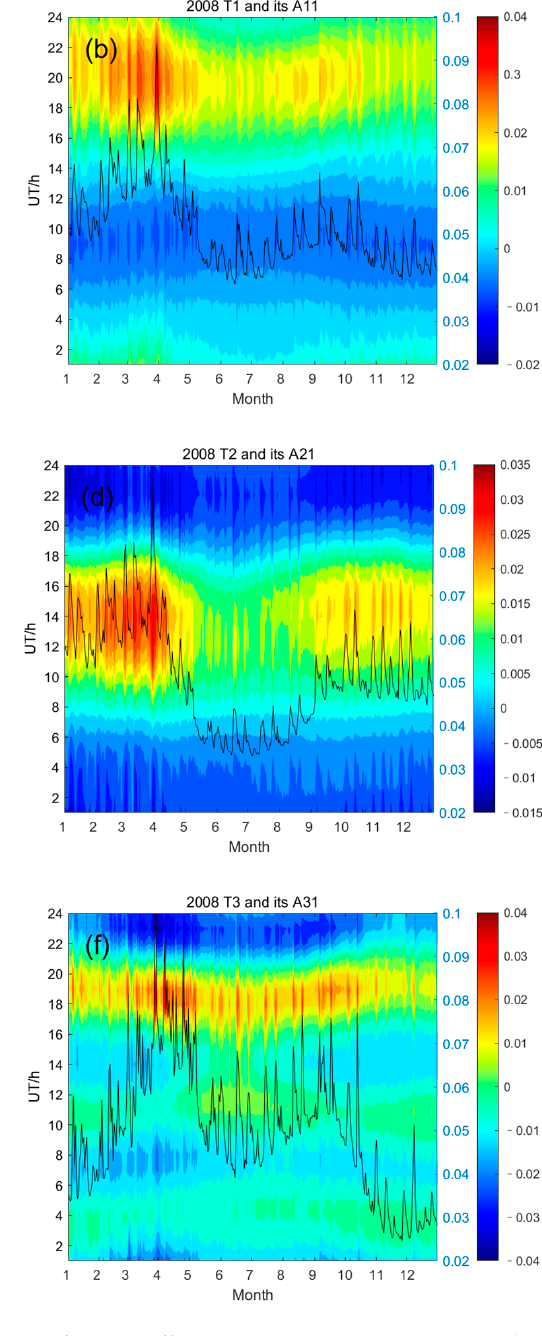
Figure 3. The diurnal and annual variations of time coefficients Ti(t) (i = 1, 2, 3) corresponding to the first three EOF i (i = 1, 2, 3) in the SAA in each of 2002 and 2008 are shown (color figure), and the annual variation curves A i1 (black curve) obtained by performing an EOF on the corresponding time coefficients are superposed on the color fi gures. Table 3. The correlation coe ffi cients obtained from the correlation analysis of the A i1 annual variation curve with Dst, F10.7, and Ap in 2002 and 2008.